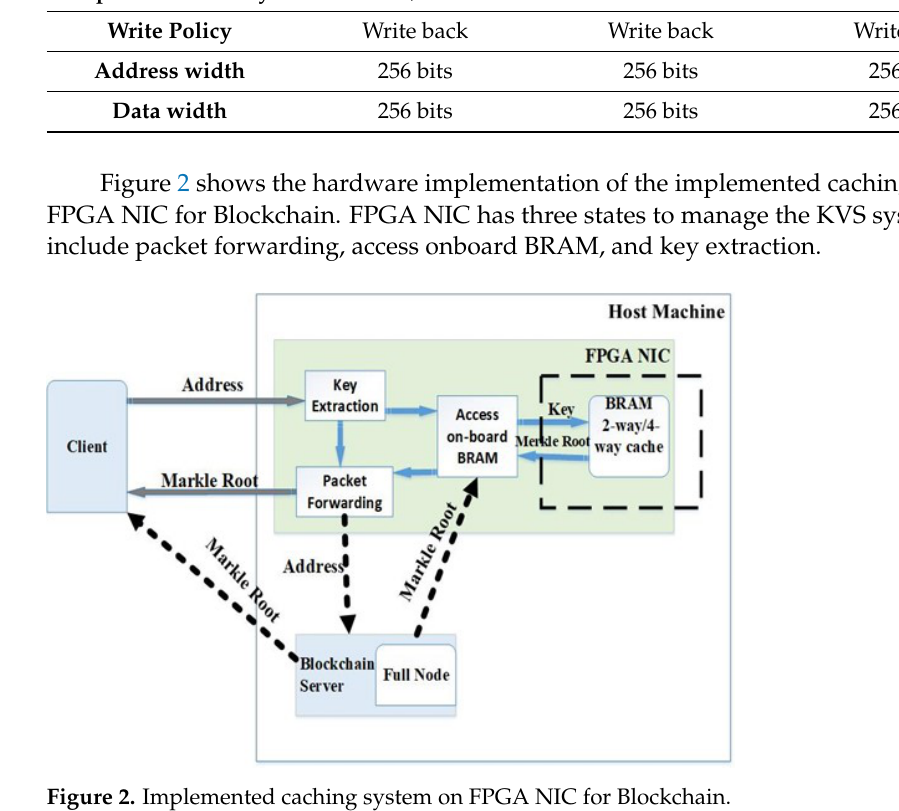
Figure 2. Implemented caching system on FPGA NIC for